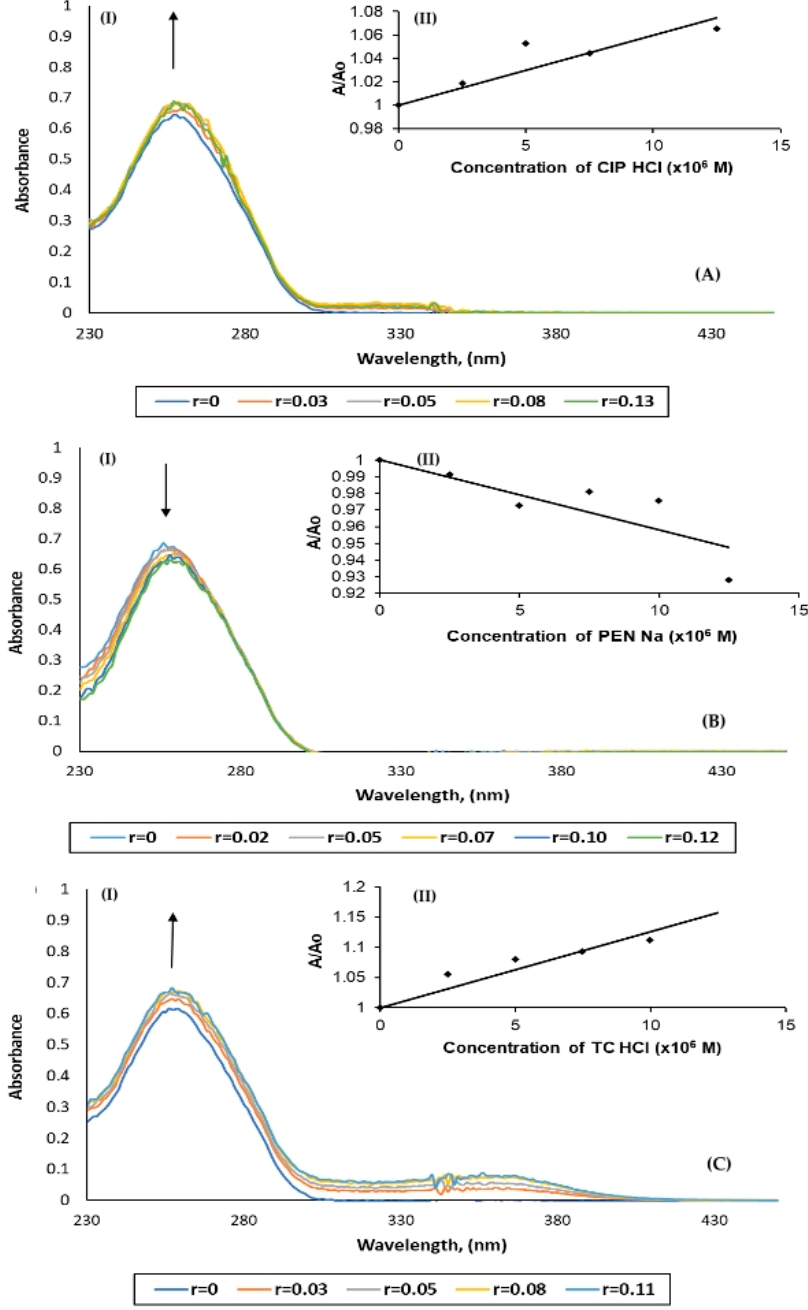
Figure 1. (I) UV spectra of CT-DNA in buffer solution in the absence and presence of ( A ) CIP·HCl , ( B ) PEN·Na , and ( C ) TC·HCl at r values (r = [compound]/[DNA], r = 0, 0.03, 0.05, 0.08, 0.13, and [DNA] = 9.7 × 10 − 5 M ( CIP·HCl ), r = 0, 0.02, 0.05, 0.07, 0.10, 0.12, and [DNA] = 10.0 × 10 − 5 M ( PEN·Na ) and r = 0, 0.03, 0.05, 0.08, 0.11, and [DNA] = 9.4 × 10 − 5 M ( TC·HCl )) and (II) plot of A/A o vs. [compound] at λ max = 257 nm (A/A o = DNA solution absorbance in the presence of DNA-binder (A) and without DNA-binder (A o )).